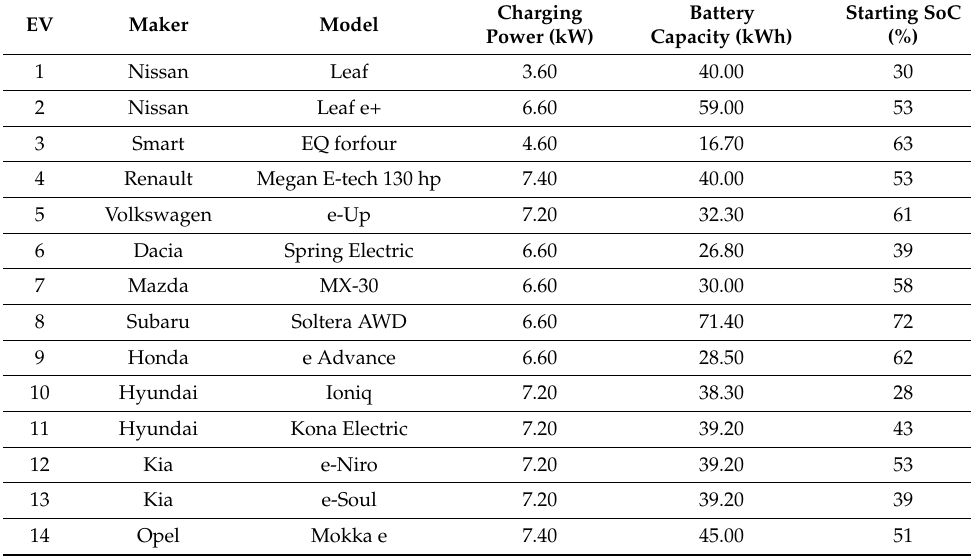
Table A1. EV details and starting SoC